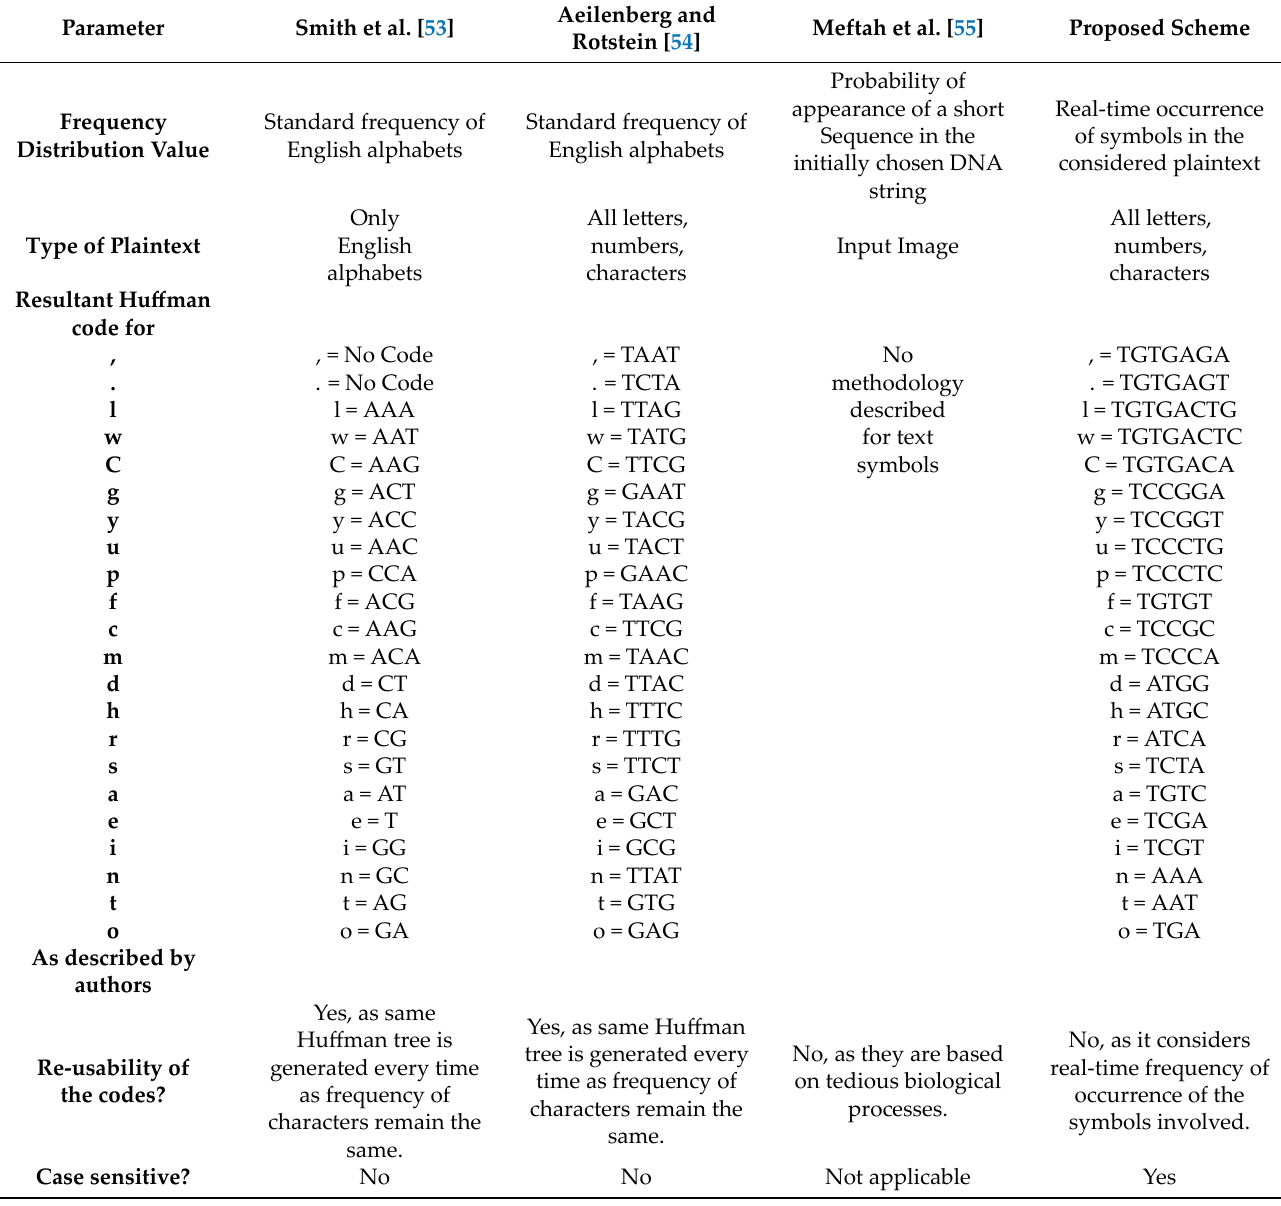
Table 12. Comparison of Proposed Cipher Generation Scheme with Existing Similar